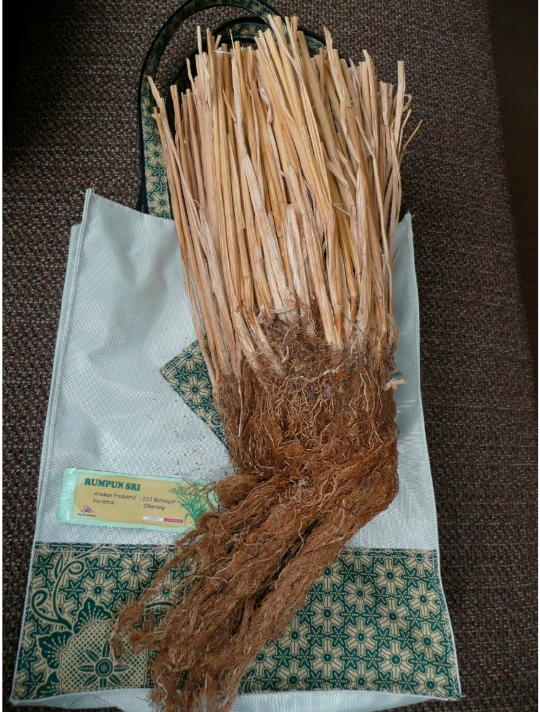
Figure 3. Rice plant (Ciherang improved variety) grown using SRI methods from a single seed near Malang, East Java, Indonesia, presented by farmers to Norman Uphoff in 2009. (Photo by Norman Uphoff.)